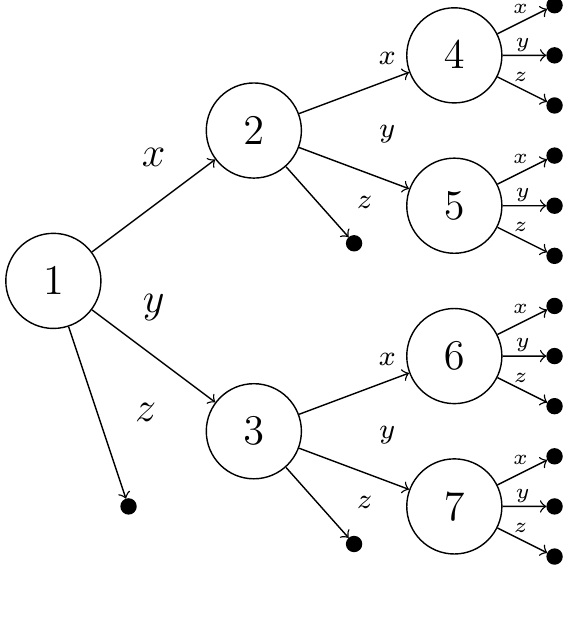
Figure 4: Deterministic finite automaton (DFA) for a binary tree with additional leaf nodes.